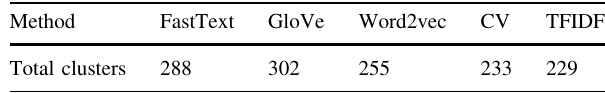
Table 4 Total number of extracted tweet clusters